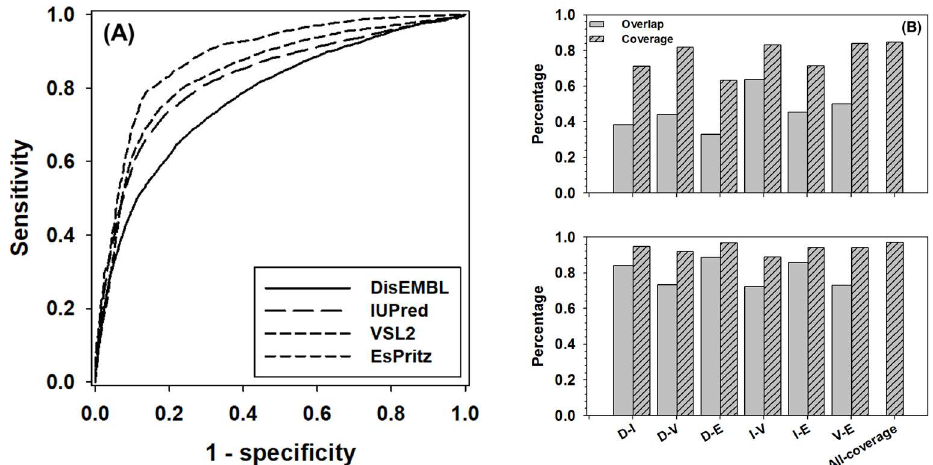
Figure 1. Prediction performance of four component predictors, including DisEMBL, IUPred, VSL2, and ESpritz. ( A ) ROC curves of four component predictors. The ROC curves were obtained by using the default settings of these predictors. ( B ) The pairwise overlap (gray bars) and coverage (dashed bars) for true positive predictions (upper panel) and true negative predictions (lower panel) between each pair of predictors. Axis shows pairs of predictors as follows: D-DisEMBL, I-IUPred, V-VSL2, and E-ESpritz. All-coverage on x -axis stands for the maximum coverage of all predictors.